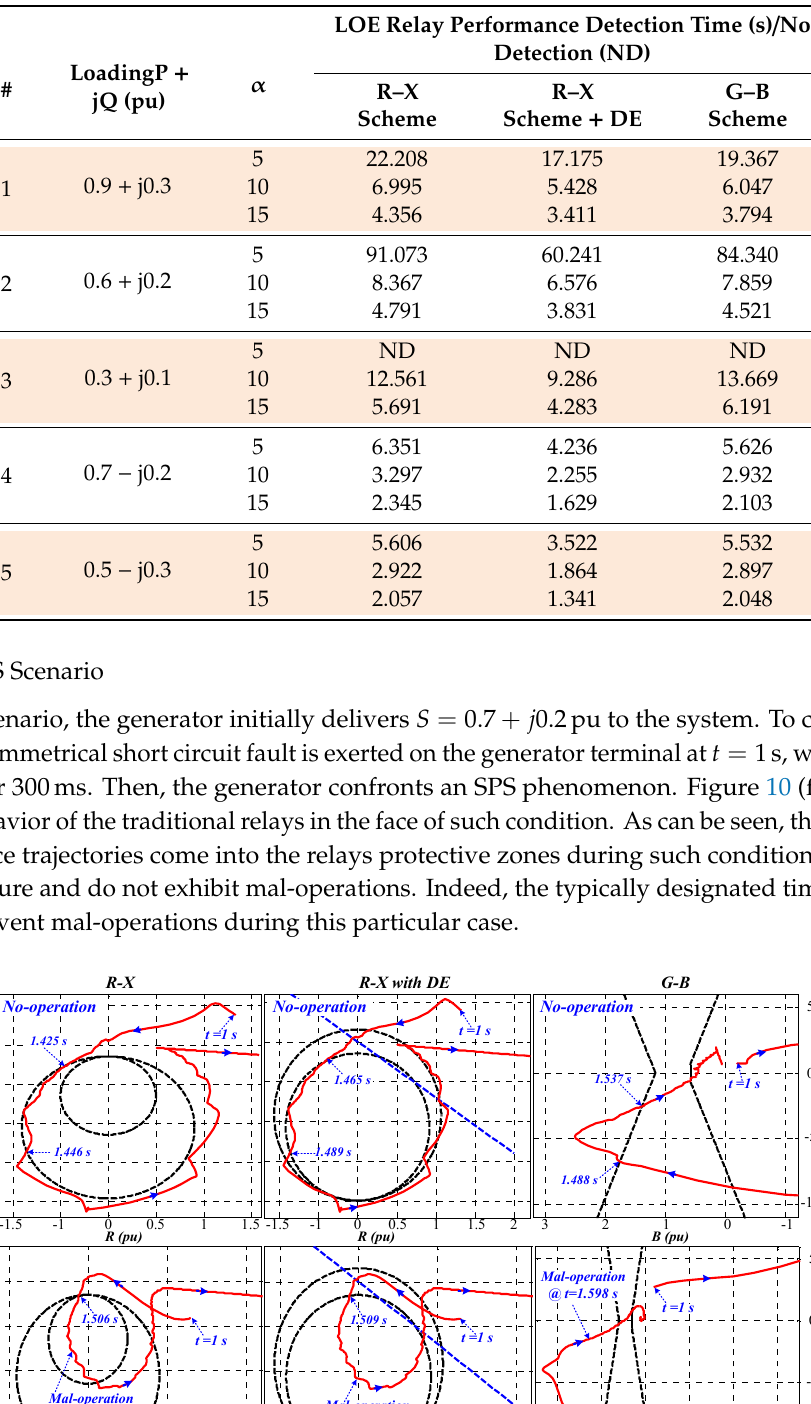
Table 3. PLOE detection by traditional schemes in di ff erent loading levels.